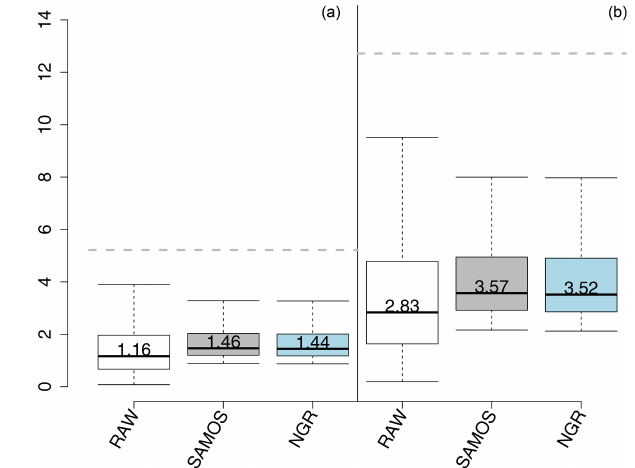
Figure 5. Boxplots of the widths of prediction intervals of 50% (a) and 90% (b) , respectively, from bootstrapping probability distribu- tions of RAW, SAMOS and NGRVC for all stations combined with the value of the median given. The dashed lines mark the respective interval widths of the SAMOS climatology .